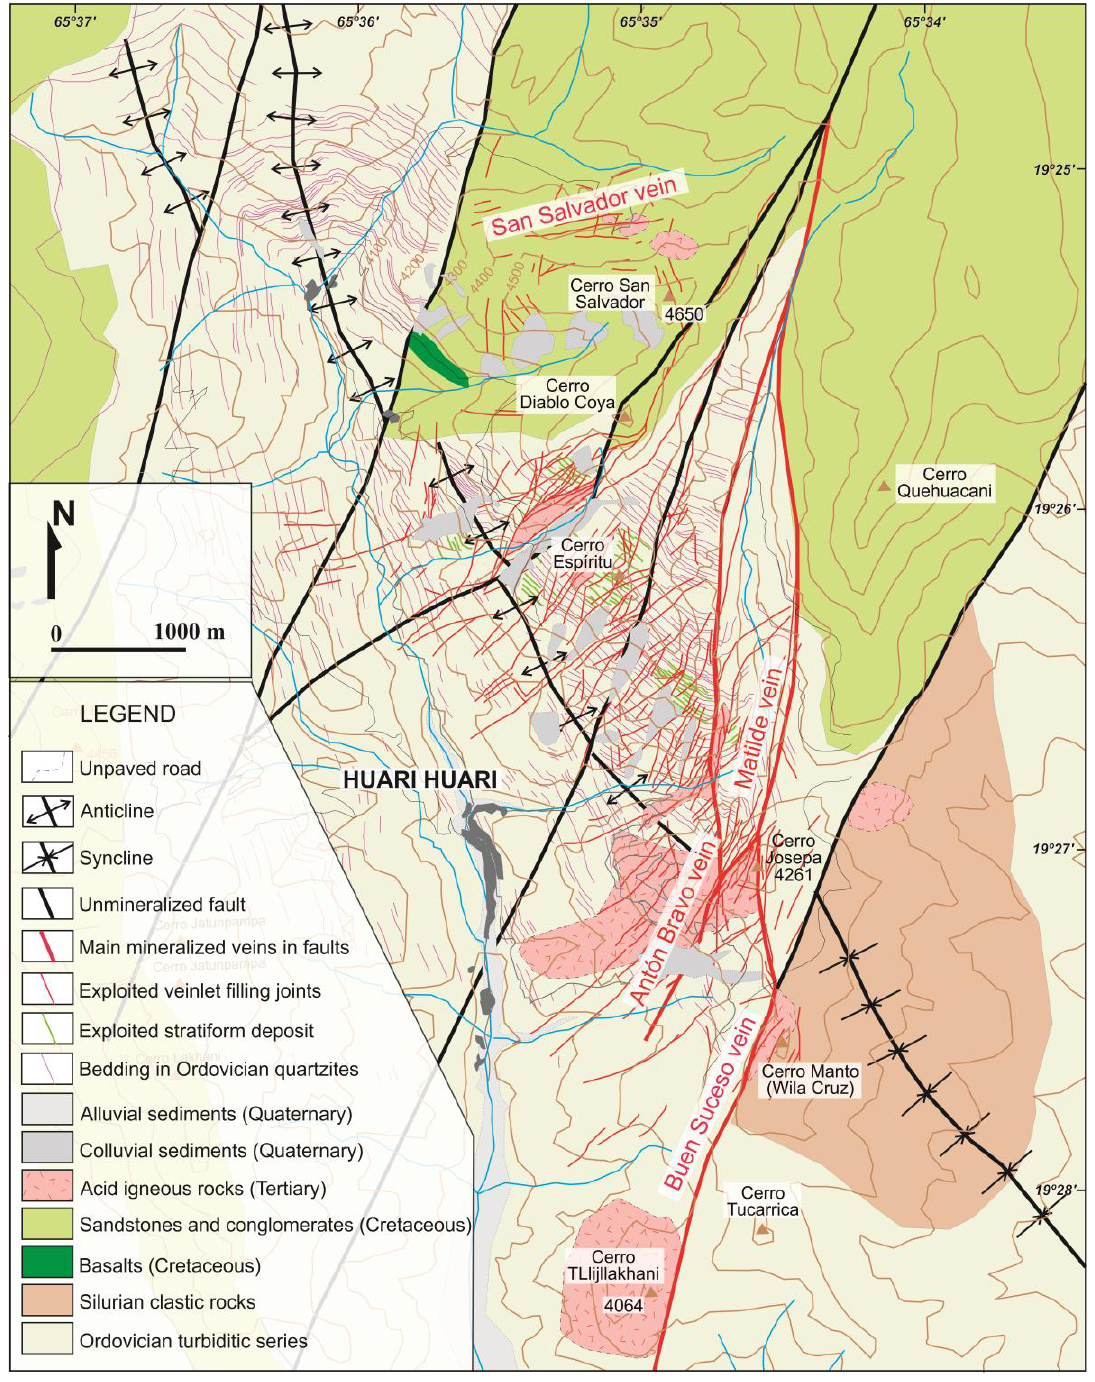
Figure 2. Geological map showing the distribution of veins in the Huari Huari mining district. The location of this map is shown in Figure 1. location of this map is shown in Figure